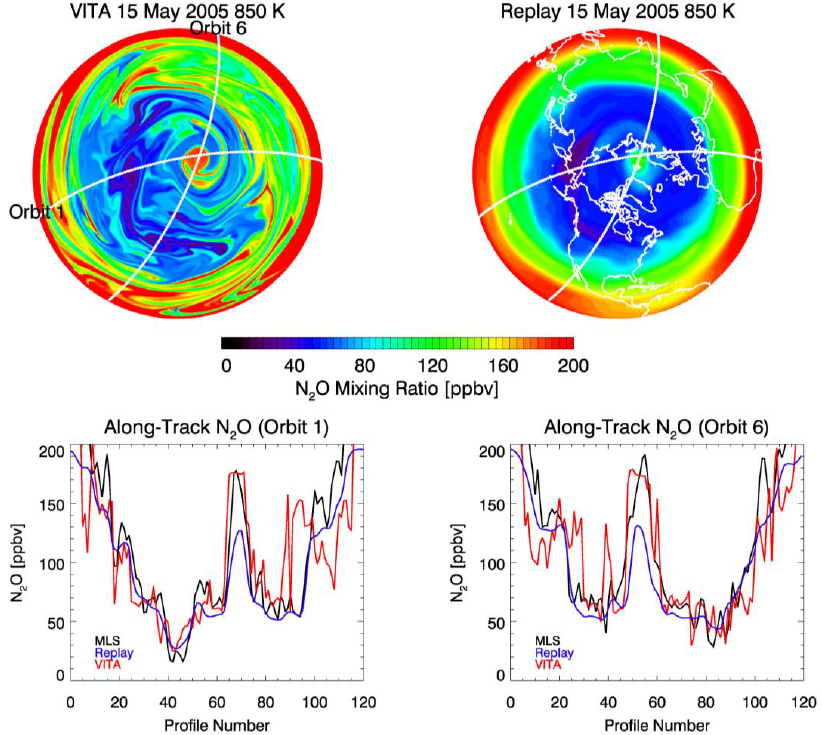
Fig. 11. Top row: Northern Hemisphere VITA (left) and Replay (right) N 2 O at 850K on 15 May 2005. Red (blue) indicates high (low) N 2 O values. Overlaid are two EOS Aura MLS orbit tracks for this day. Second row: MLS, Replay, and VITA N 2 O at 850K along the selected orbit tracks. The profiles start at the locations of the orbit labels in the upper left panel. Replay and VITA data are interpolated linearly in space and time to the MLS data points.